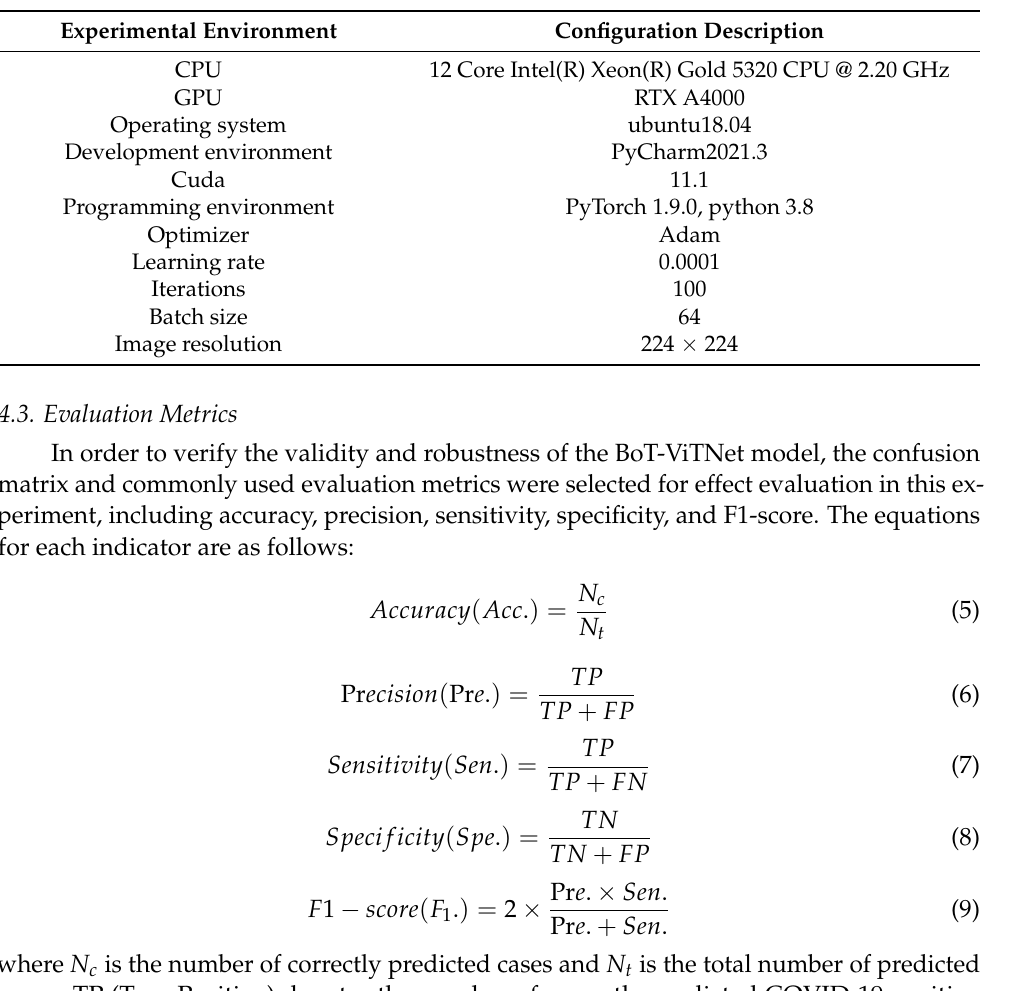
Table 4. The configuration of the environment and parameters for the